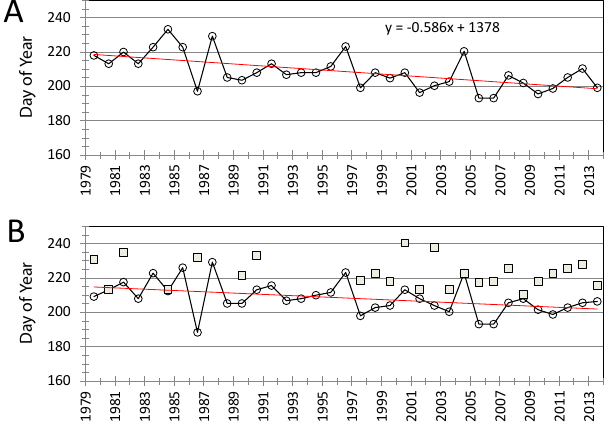
Figure 11. Temporal changes in the center of timing of the occur- rence of cyanobacteria accumulations (median of the area). (A) the whole Baltic Sea; (B) Northern Baltic Proper (circles connected by solid black line) and Bothnian Sea (gray squares). Red line is the estimated linear regression for the whole Baltic (A) or the North- ern Baltic Proper (B) . 1 July is day-of-year 182 (day-of-year 183 on leap years), day-of-year 200 is 18 July (19 July on leap